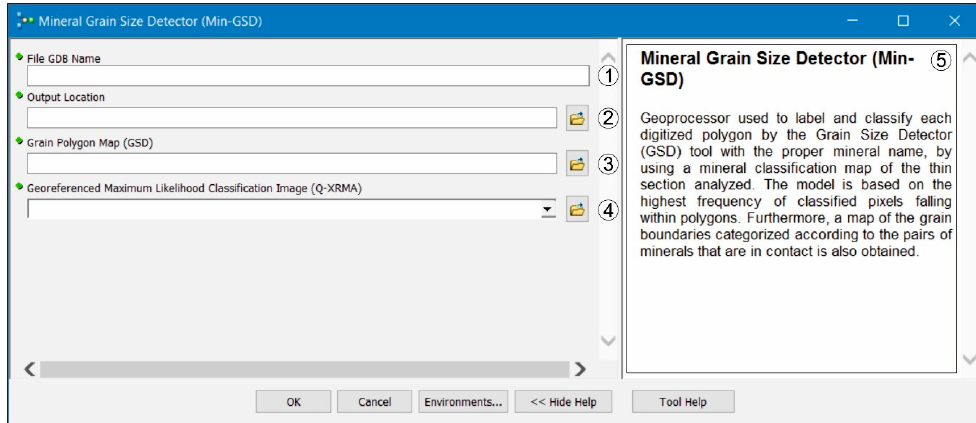
Figure 5. ArcGIS ® Graphical User Interface of the Min-GSD tool: ( 1 ) the name of the investigated sample; ( 2 ) the path of the outputs folder; ( 3 ) the polygon map obtained by the GSD tool; ( 4 ) the georeferenced mineral classification map obtained by the Q-XRMA; ( 5 ) the help menu of the tool showing hints about the required inputs. Green circles on the left side mark mandatory inputs.